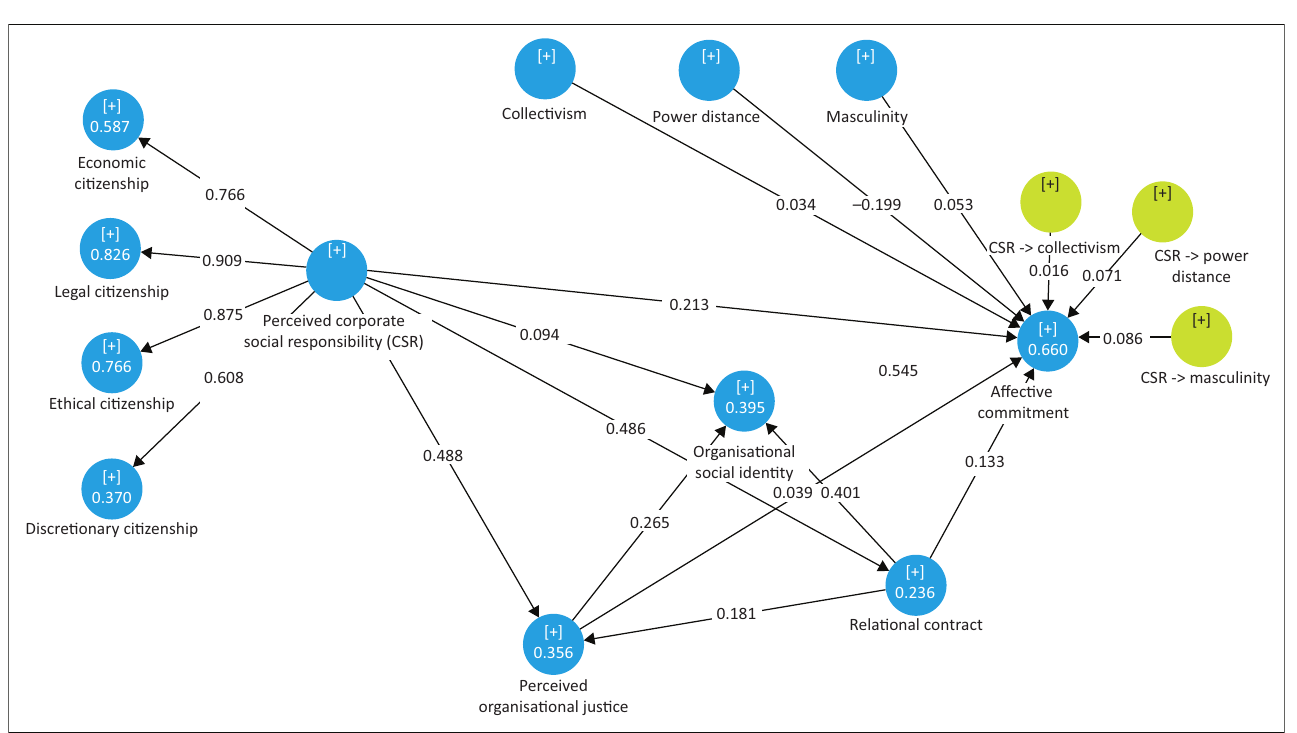
FIGURE 2: Structural Model with Path